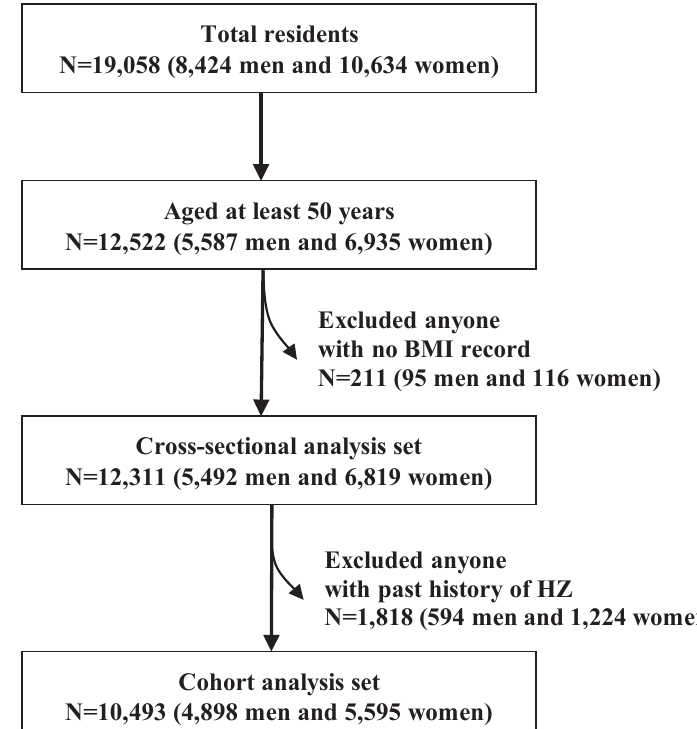
Figure 1. Flow chart for the